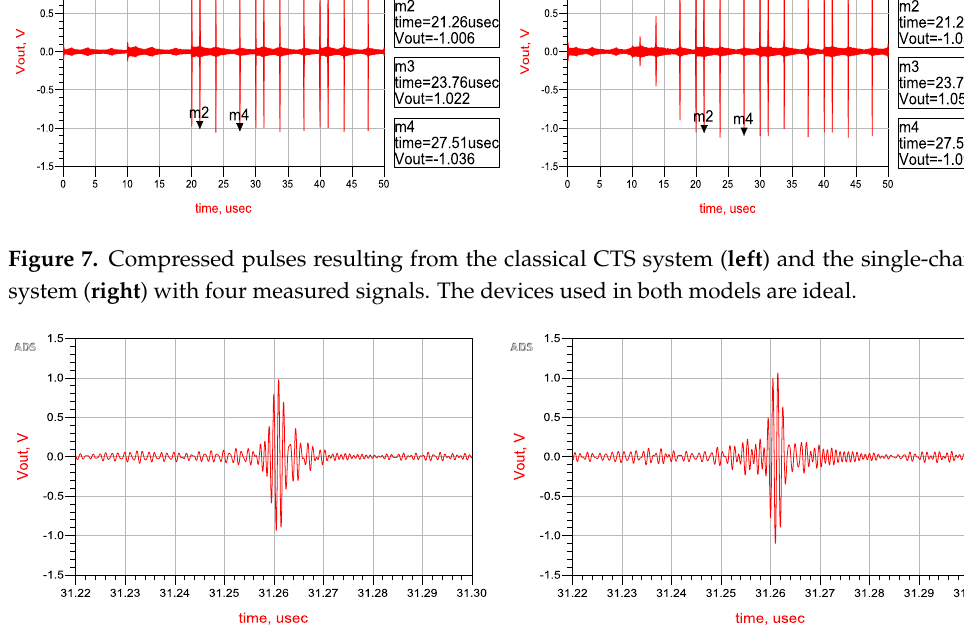
Figure 8. An enlarged comparison version of one single pulse at 31.26 us from the classical CTS system ( left ) and the single-channel system ( right